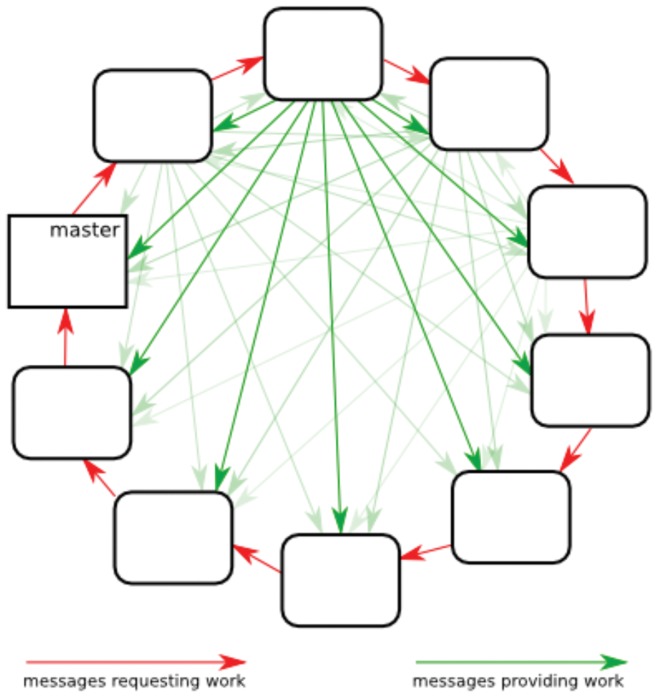
Ring Graph Parallelization Diagram for Crumple.Red Arrows indicate the direction of requests for work. Green arrows indicate the flow of distributed work. One node is arbitrarily selected as the first and master node.